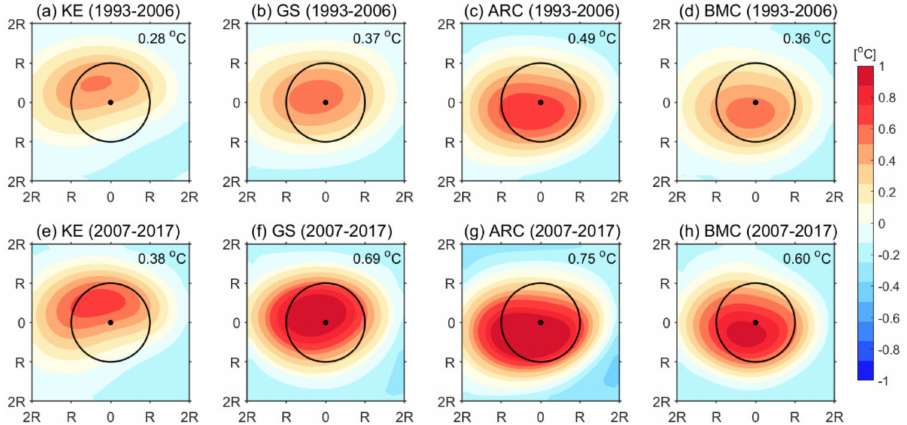
Figure 8. The composite Anticyclonic Eddy (AE)-induced SSTA in the ( a , e ) KE, ( b , f ) GSE, ( c , g ) ARC, and ( d , h ) BMC regions during the periods of ( a – d ) 1993–2006, and ( e – h ) 2007–2017 based on the OI.v2-AVHRR-only data. The circles denote the normalized eddy radius, and the dots are the eddy